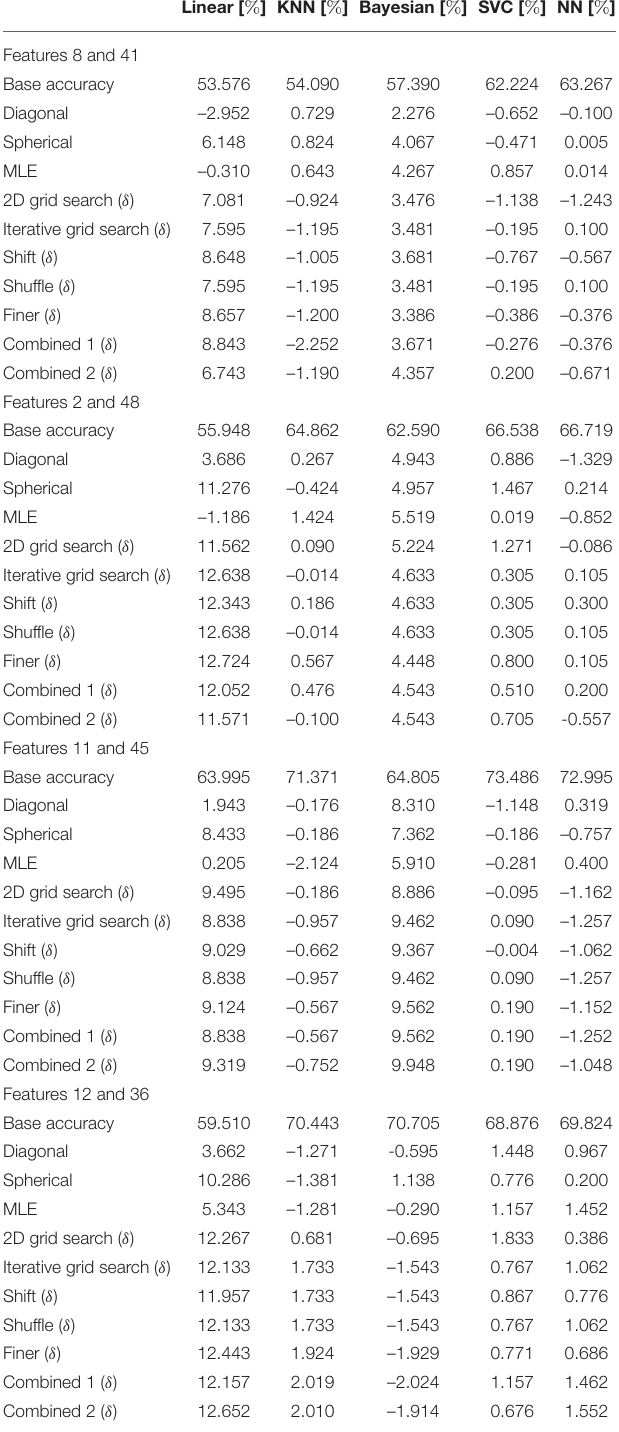
TABLE 7 | Improvement δ in accuracy for different iterative optimization settings on the breast cancer